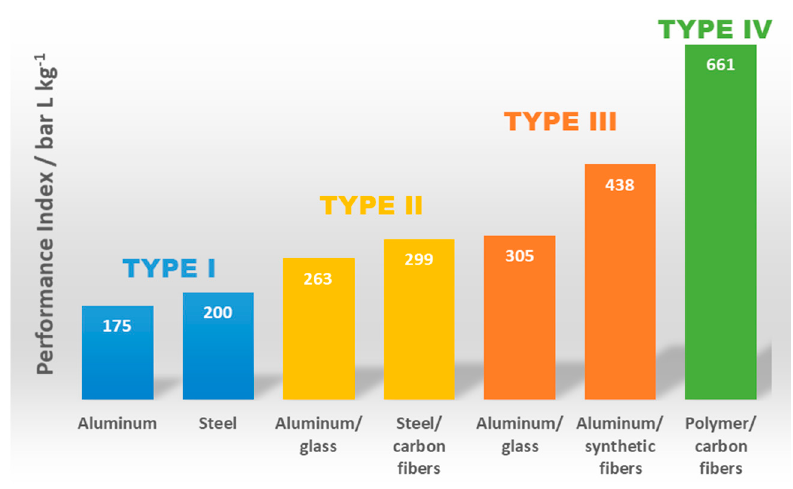
Figure 2. Di ff erent typologies of high-pressure hydrogen tanks and their performance indexes Figure 2. Different typologies of high-pressure hydrogen tanks and their performance indexes (adapted from (adapted from [27]).